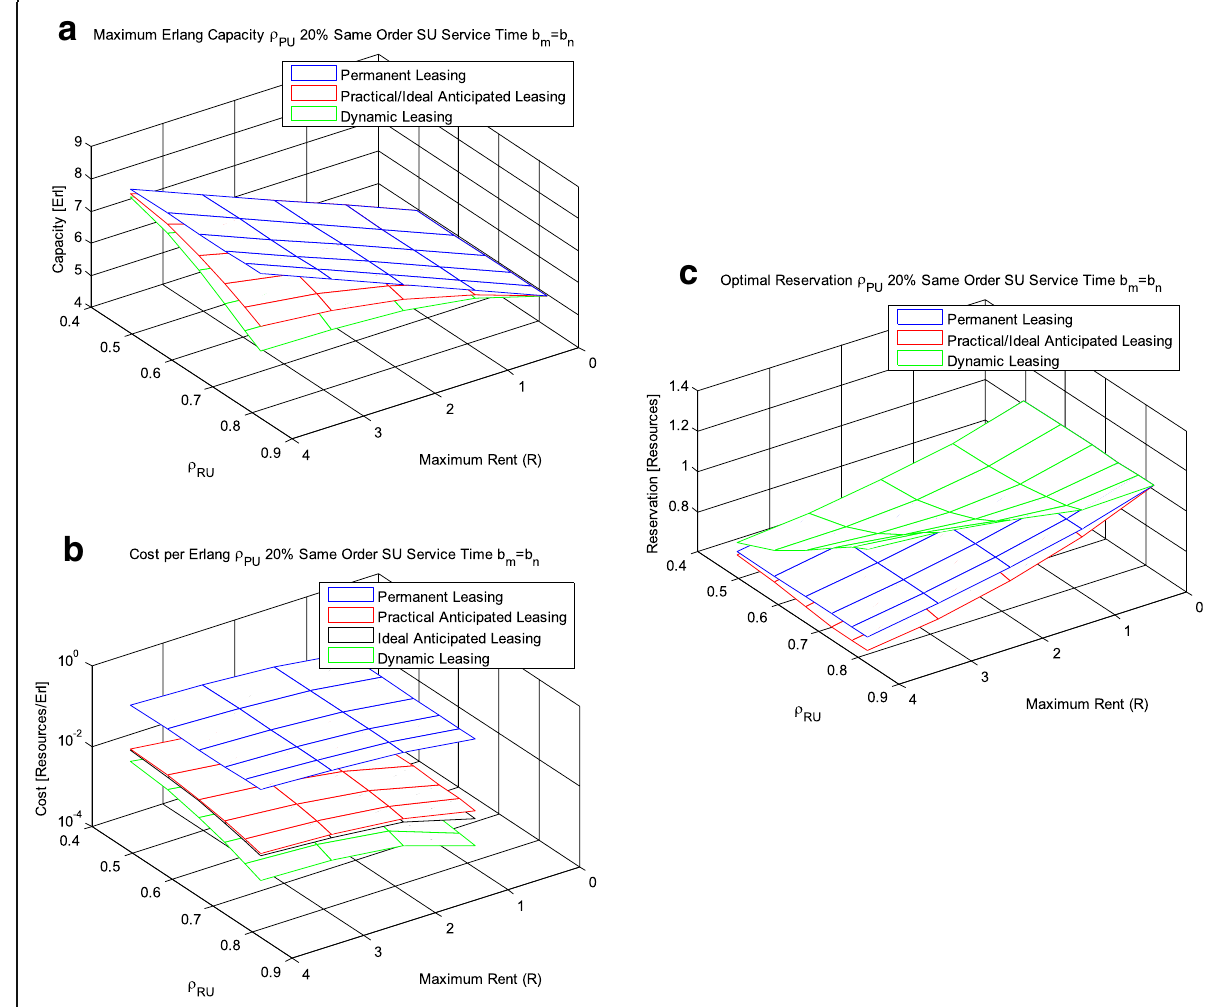
Fig. 6 Performance of spectrum leasing strategies under the system scenario in which ρ PU = 0.2, μ m / μ n = 1, and b m = b n . a Maximum Erlang capacity, b cost per rented resource per achieved Erlang capacity, and c optimal number of reserved channels as function of R and ρ